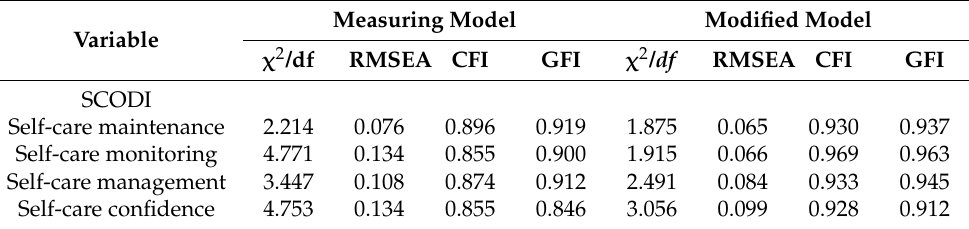
Measuring Model